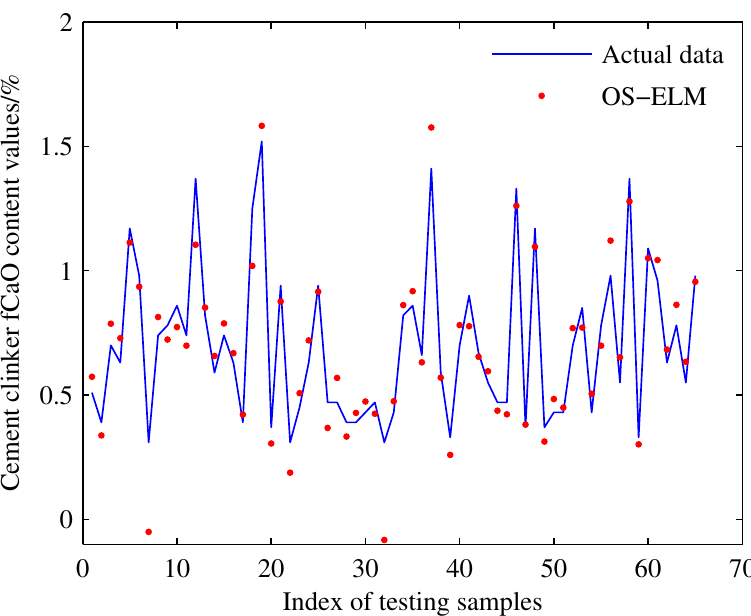
Figure 5. Simulation result of fCaO online prediction model with OS-ELM for testing data.